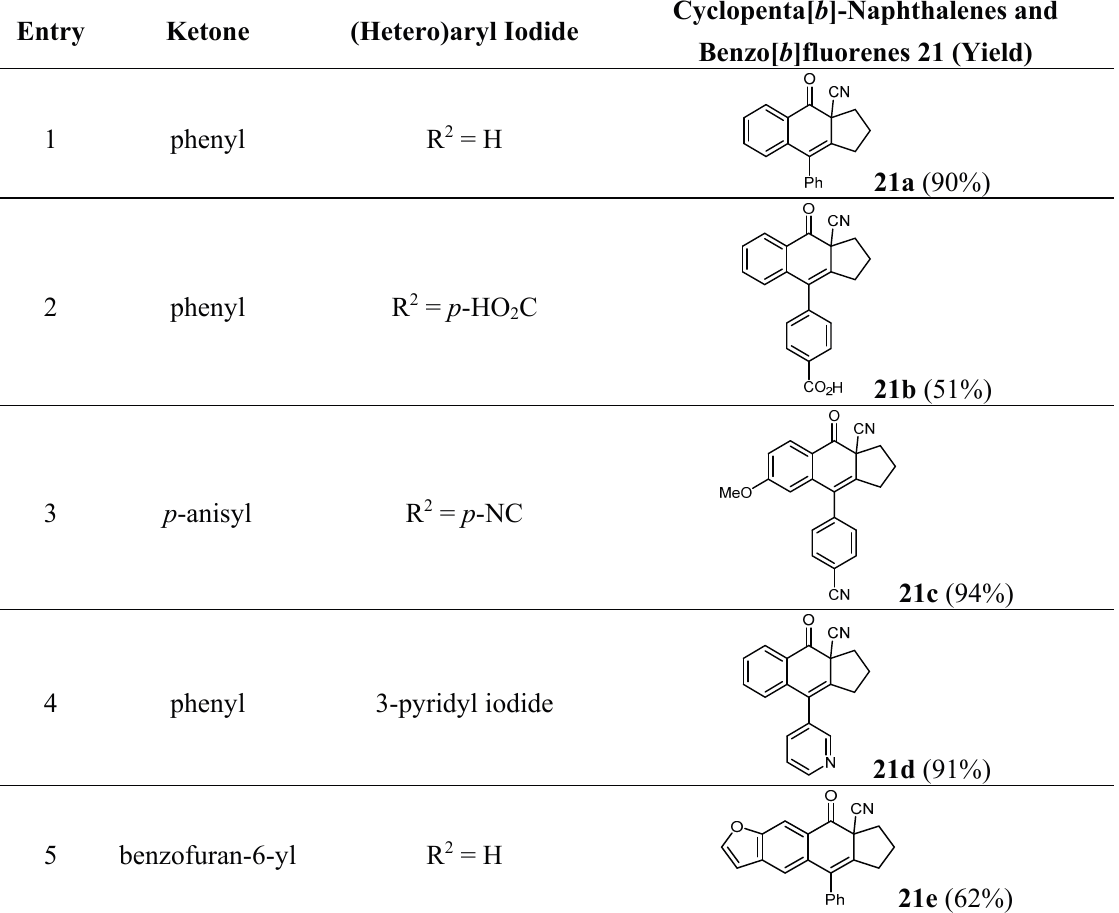
Table 5. Selected cyclopenta[ b ]naphthalene and benzo[ b ]fluorene derivatives 21 prepared by the sequential Pd-Cu-catalyzed Sonogashira coupling-Cu-catalyzed cyclization. Entry